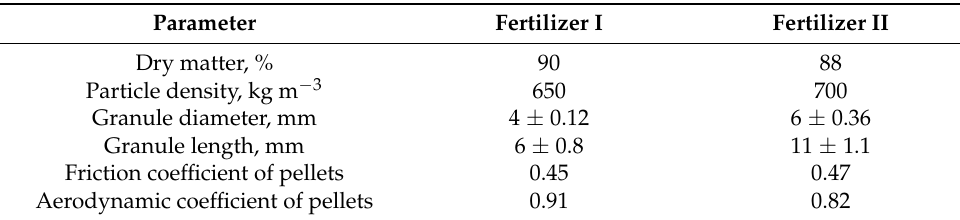
Table 1. Main physical – mechanical parameters of granular organic fertilizers. Parameter